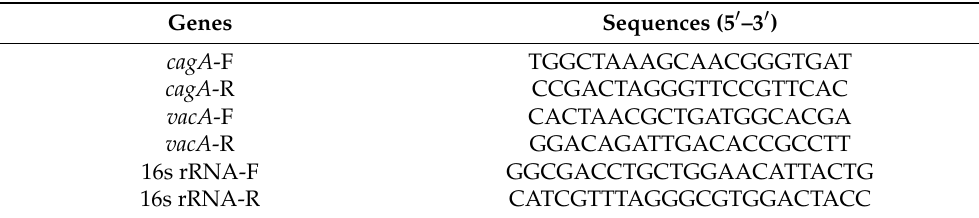
Table 1. Real-time PCR